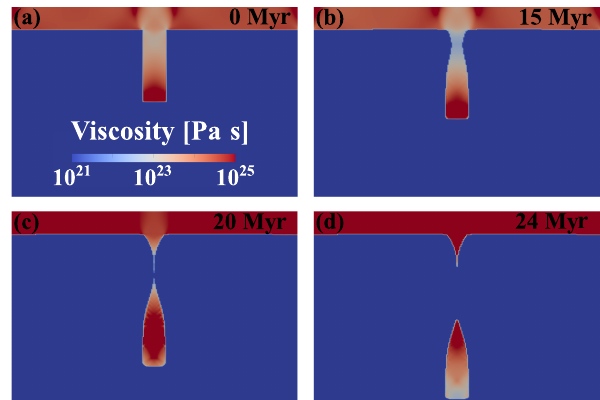
Figure 12. Detachment benchmark model evolution showing the viscosity field over time. After about 20Myr, necking is complete and the remaining lithosphere reaches a high, uniform viscosity.